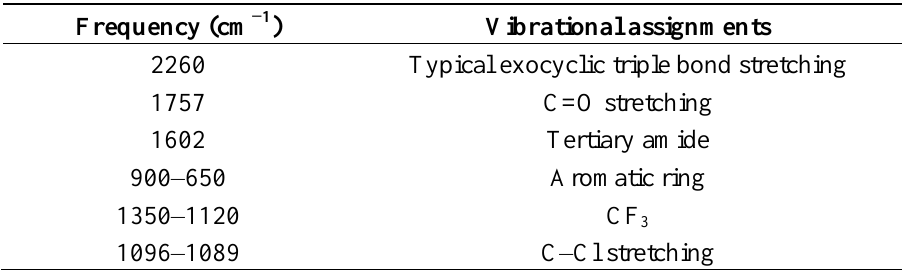
Table 2. Characteristic infrared absorption bands of EFV.